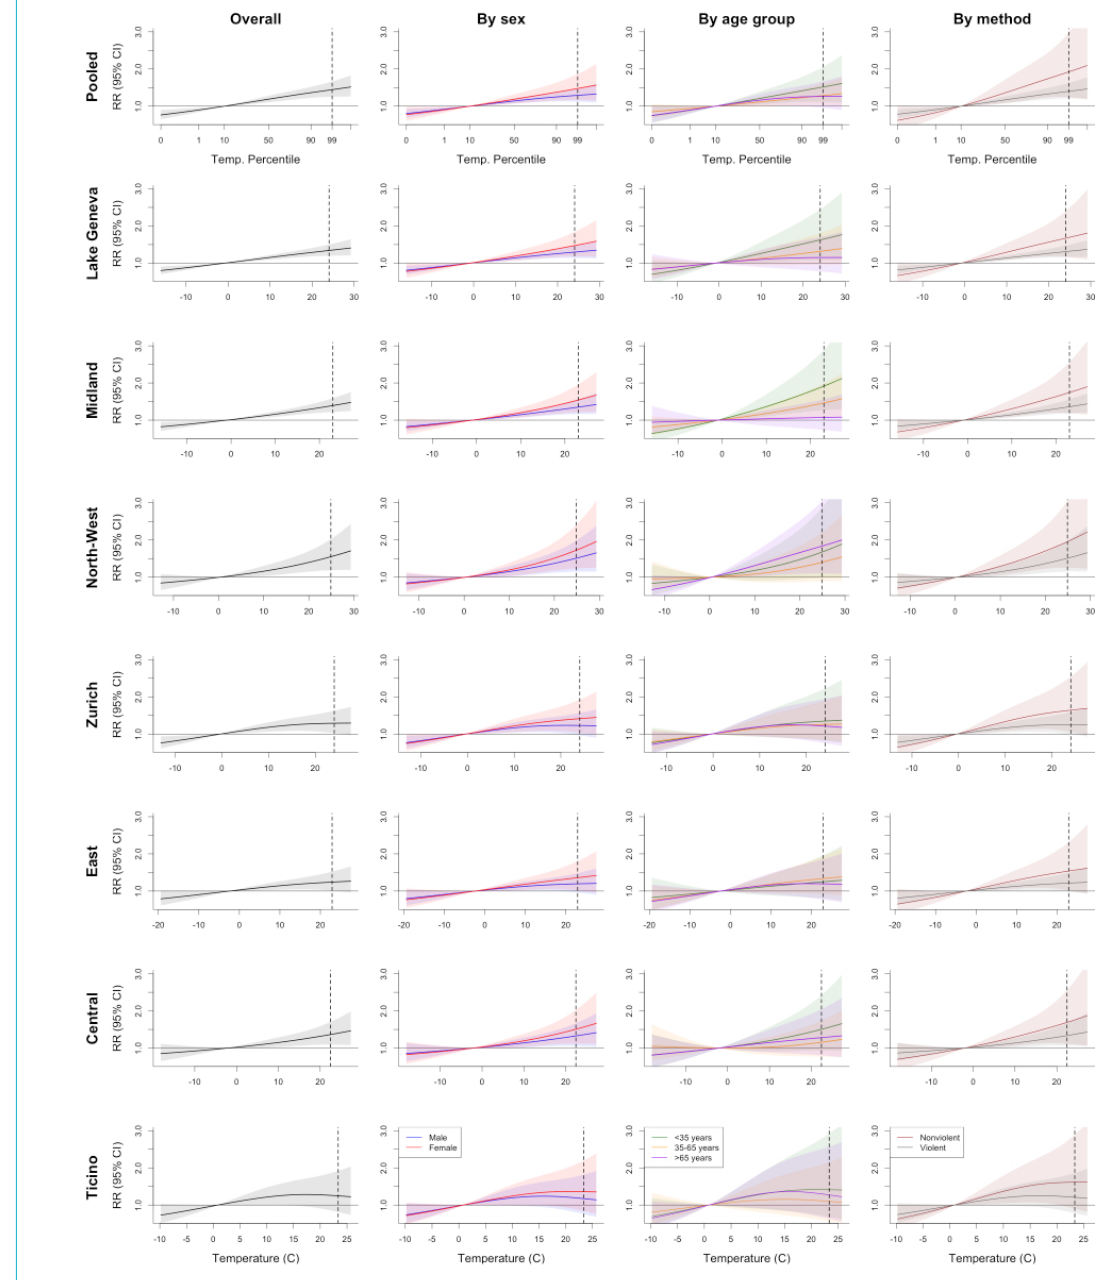
Figure 1: Exposure-response curves of the temperature-suicide association overall and across the seven major regions of Switzerland. Rela- tive risk (RR) of suicide with the 95% CI (transparent colour) against daily mean temperature (°C) with the corresponding 99 th percentile of the temperature distribution (dashed line). Overall exposure-response curves for each region and for pooled data, and stratified analyses by sex, age group and method of